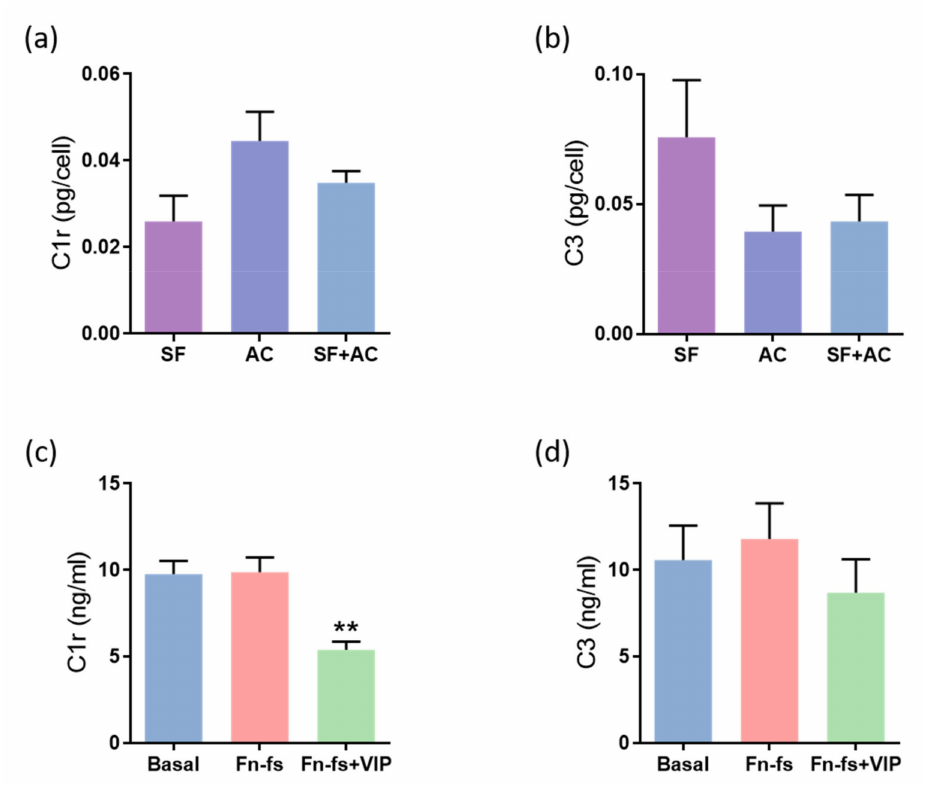
Figure 4. VIP-modulated complement system proteins. Secreted levels of ( a , c ) C1r and ( b , d ) C3 were determined by ELISA and Multiplex, respectively, in the secretomes from SF and AC alone and in co-culture ( n = 6). Data are presented as mean ± SEM of triplicate determinations. ( a , b ) Constitutive protein expression of ( a ) C1r and ( b ) C3 PTX3 in the secretomes from SF and AC alone and in co-culture at 48 h. Results are presented as pg corrected by the number of cells for each condition. ( c , d ) Protein expression of ( c ) C1r and ( d ) C3 in the SF-AC co-cultures secretomes at 48 h of treatment with and without 10 nM 45 kDa Fn-fs in the presence and absence of 10 nM VIP. ** p < 0.01 Fn-fs+VIP vs.